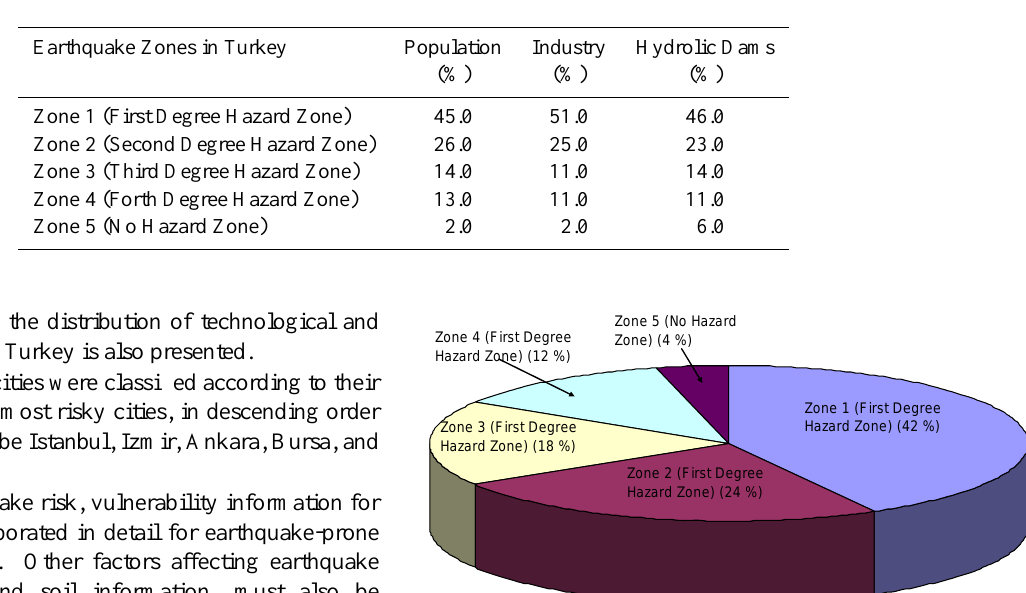
Table 6. Distribution of technological and social risk elements in Turkey obtained from the “General Management of Disaster Affairs of Turkey”.